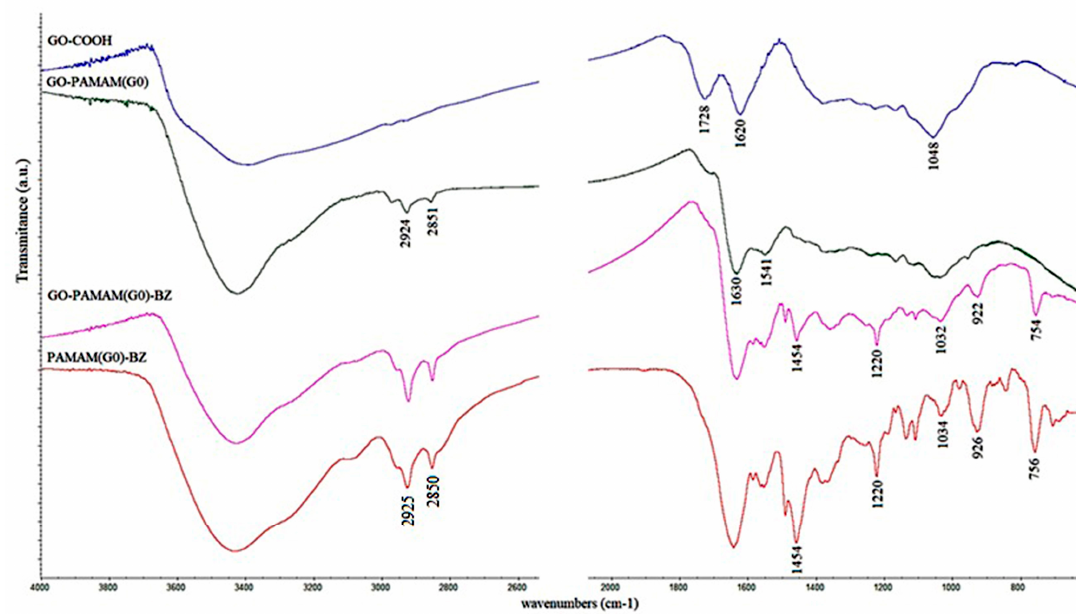
Figure 5. FT-IR spectra of hybrid monomers GO-PAMAM(G0)-BZ .